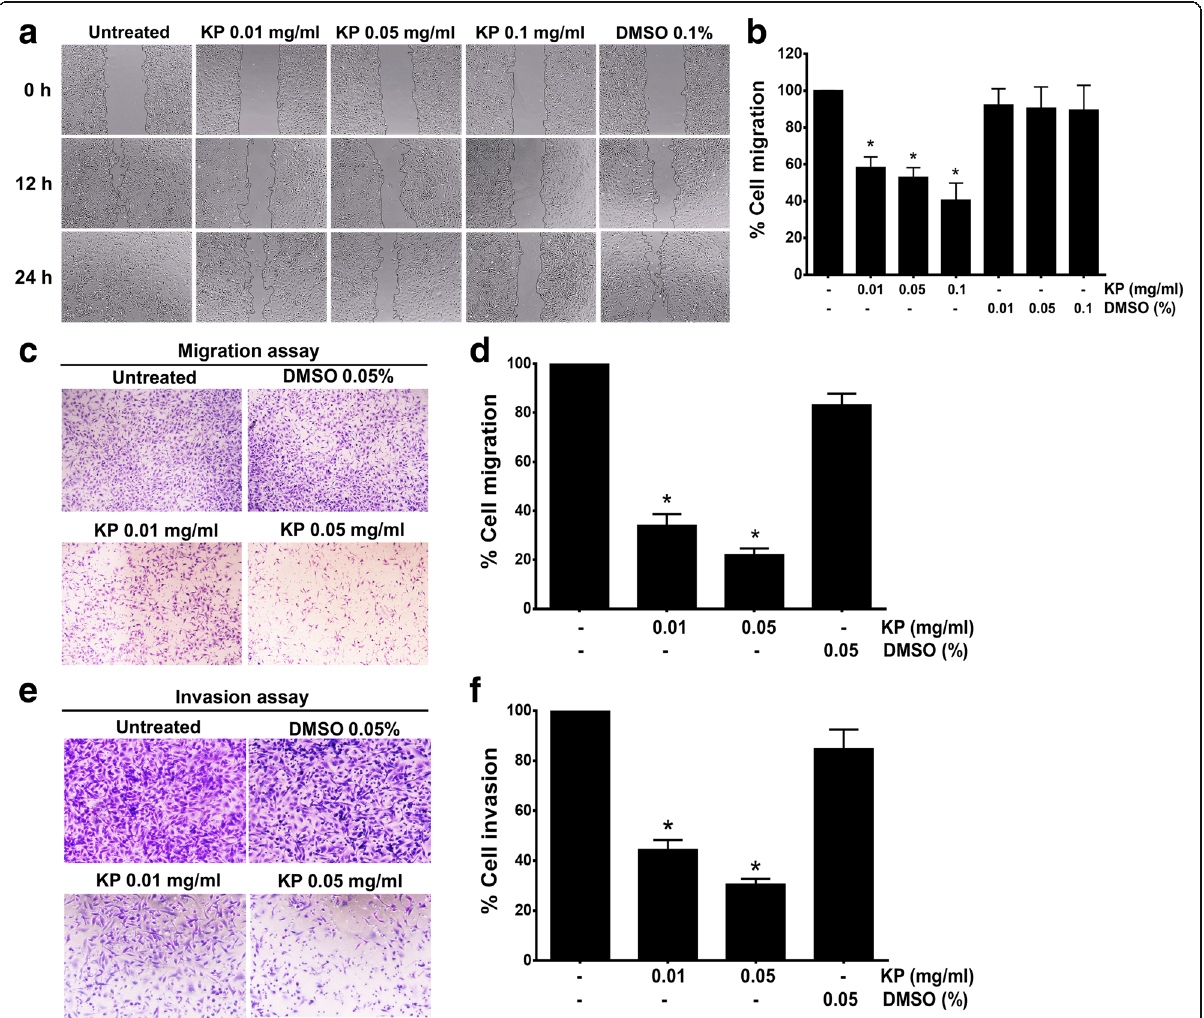
Fig. 4 The effect of KP on SKOV3 cell migration. Wound-healing assay of SKOV3 cells treated with KP ethanol extract at 0, 12, and 24 h after performing the scratch ( a ). Histogram represents the percentage of cell migration ( b ). Transwell migration assay and represented histogram are shown in c and d . Invasion assay was shown in e and f . All data were from 3 independent experiments and reported as means ± SD for measurements in quadruplicate * P < 0.05 as compared to the